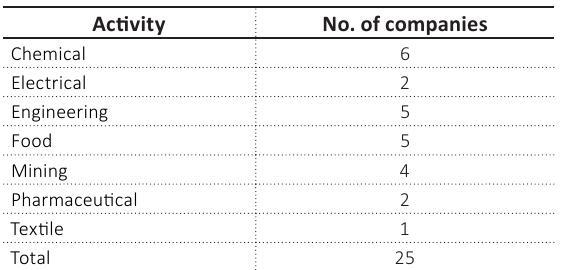
Table 1. Distribution of companies by industry